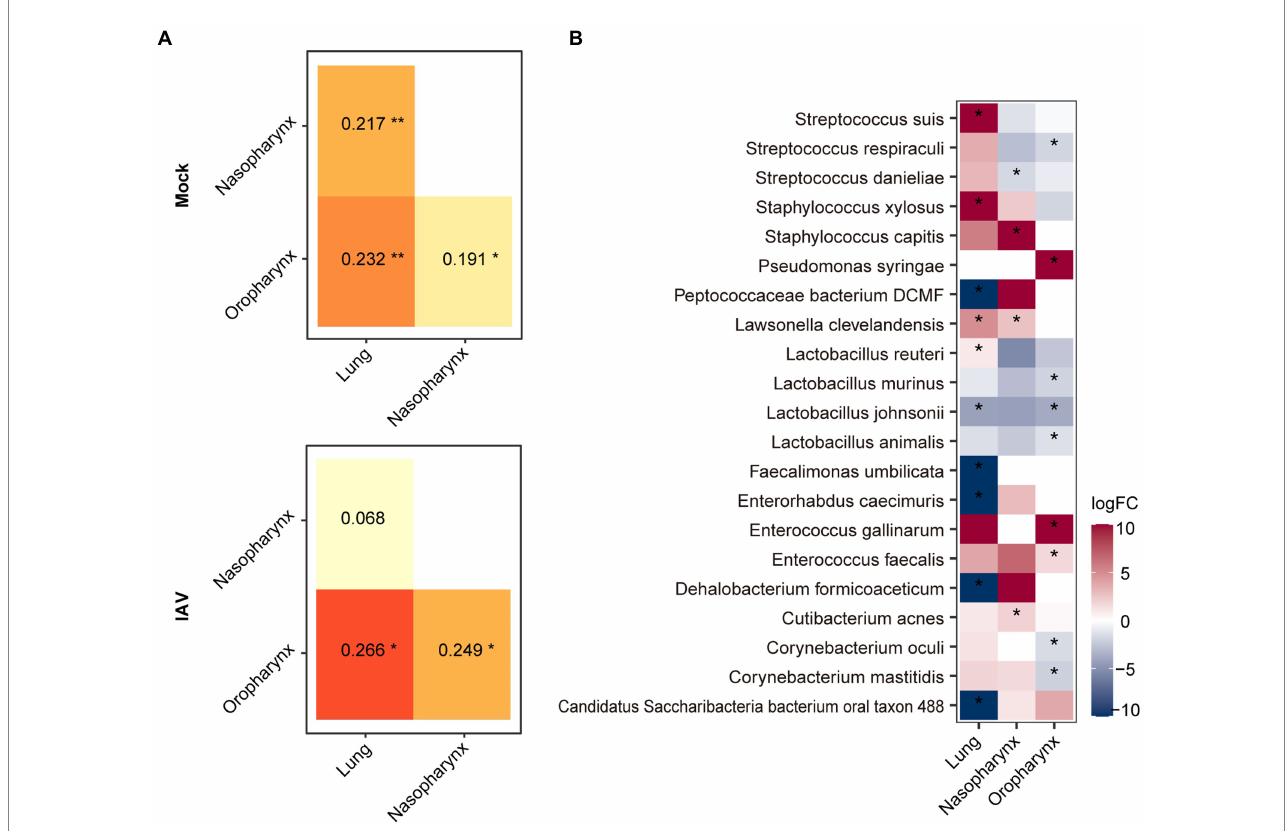
FIGURE 4 Comparison of oropharyngeal, nasopharyngeal and lung microbiota during IAV infection. (A) Similarity analysis of the microbiota of different locations in the IAV and mock groups. (B) Distribution of significantly different species between mock and IAV groups in different sampling locations. Shannon and Chao1 indices among different sampling locations were analyzed with the Mann–Whitney test. Similarity of microbiota of different locations was analyzed with ANOSIM. Bacterial taxa abundance between mock and IAV group was also analyzed with the Mann–Whitney test. *** p < 0.001, ** p < 0.01, * p < 0.05. n = 10 per